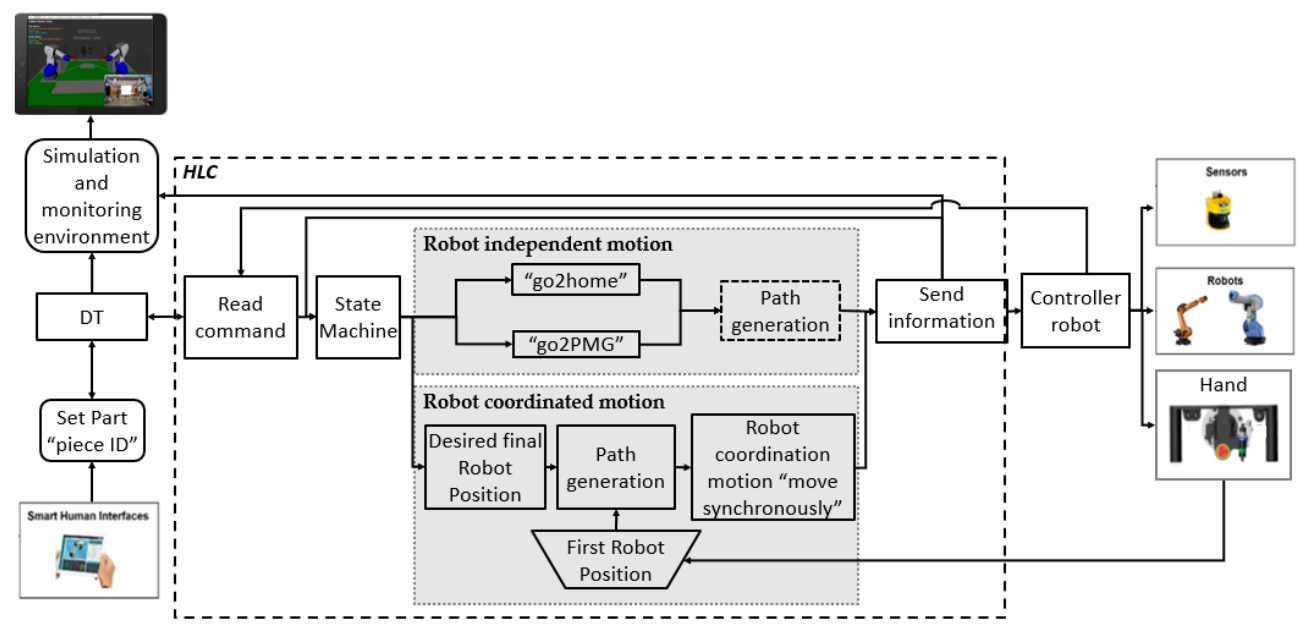
Figure 5. Block diagram of the HLC.